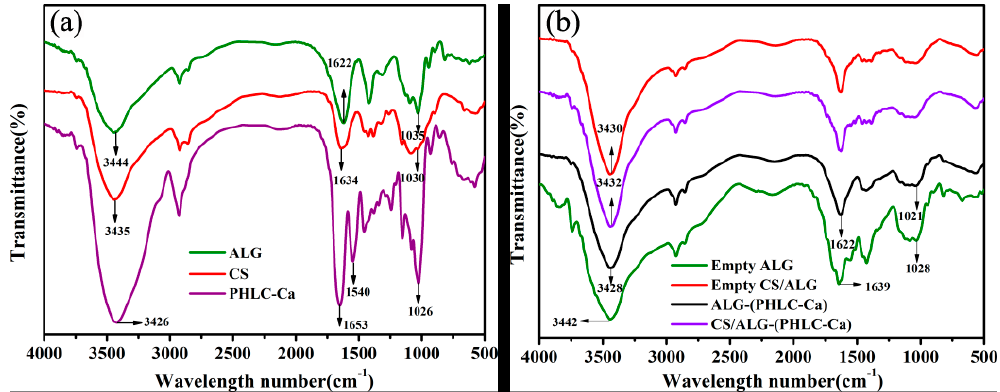
Figure 4. Fourier transform infrared (FTIR) spectra of ( a ) ALG, CS, PHLC-Ca; ( b ) Empty ALG, Empty CS/ALG, ALG-PHLC-Ca and CS/ALG-(PHLC-Ca) microcapsules.